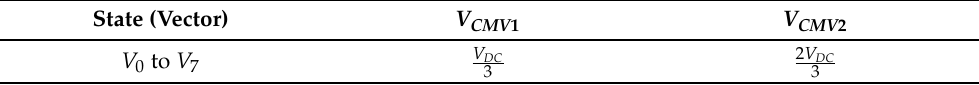
Table 2. Switching configurations of the three-phase DCM-232 transformerless